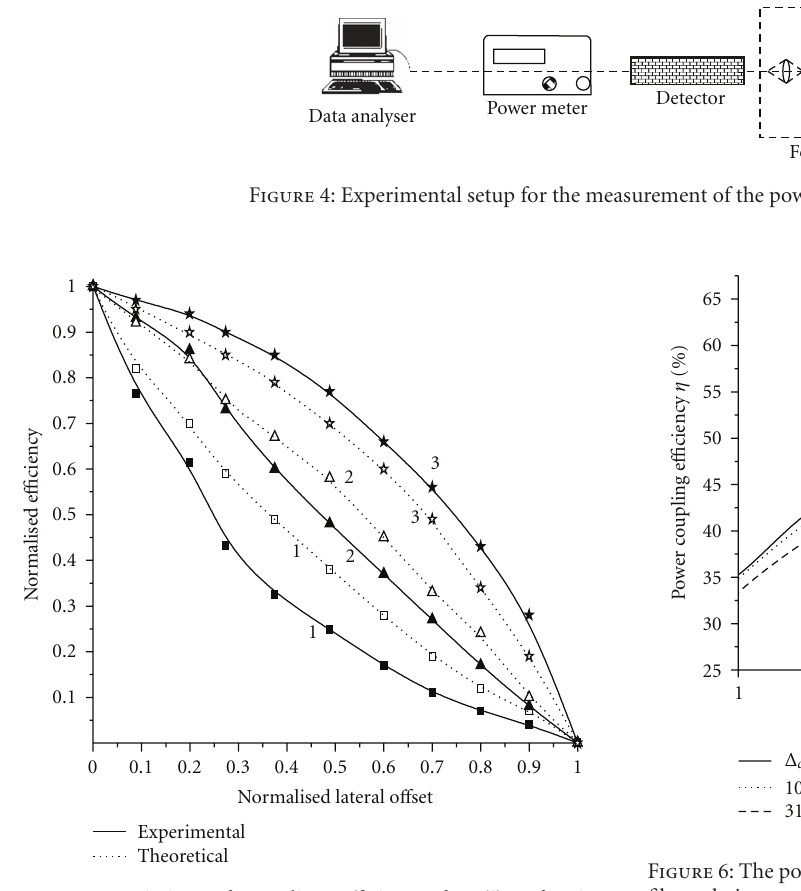
Figure 5: variation of coupling e ffi ciency for (i) refractive microlens, (ii) Di ff ractive microlens and (iii) Hybrid microlens.